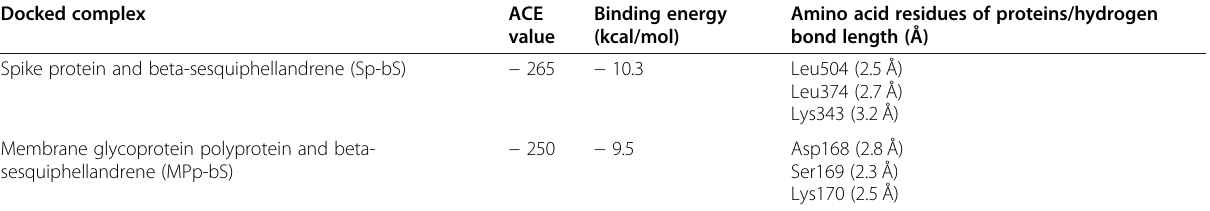
Table 1 Molecular docking and hydrogen bond analysis between viral proteins and beta-sesquiphellandrene molecule